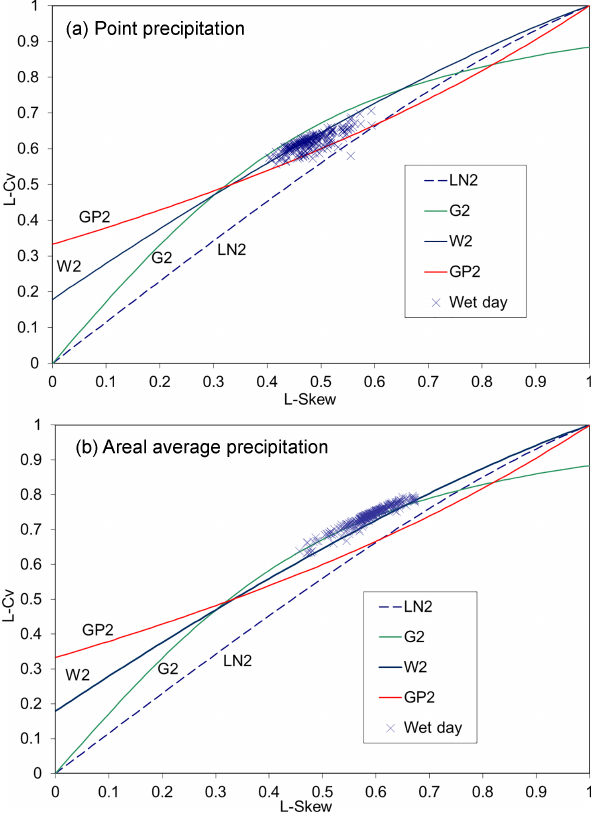
Figure 4. L-Cv vs. L-skew L-moment ratio diagram of sample L- moments and theoretical distributions: (a) point precipitation and (b) areal average precipitation